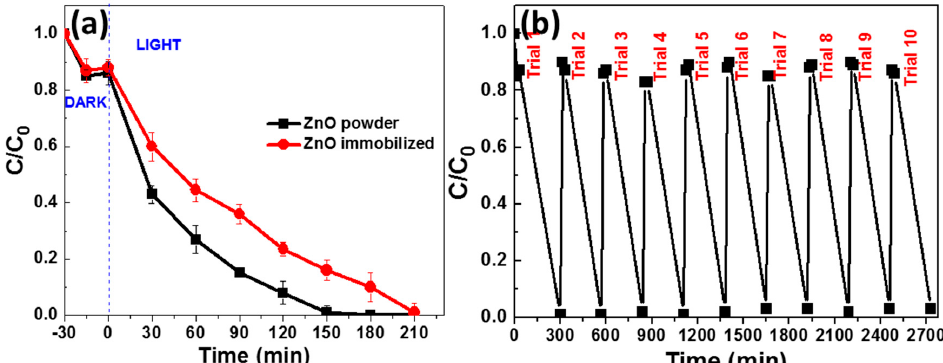
Figure 3. ( a ) Variation of the Orange II concentration as a function of irradiation time (C is the concentration at time t, and C 0 is the initial concentration). ( b ) Reusability of ZnO NRs fixed on glass slides. Experiments were performed under simulated sunlight irradiation (intensity of 5.5 mW/cm 2 ).